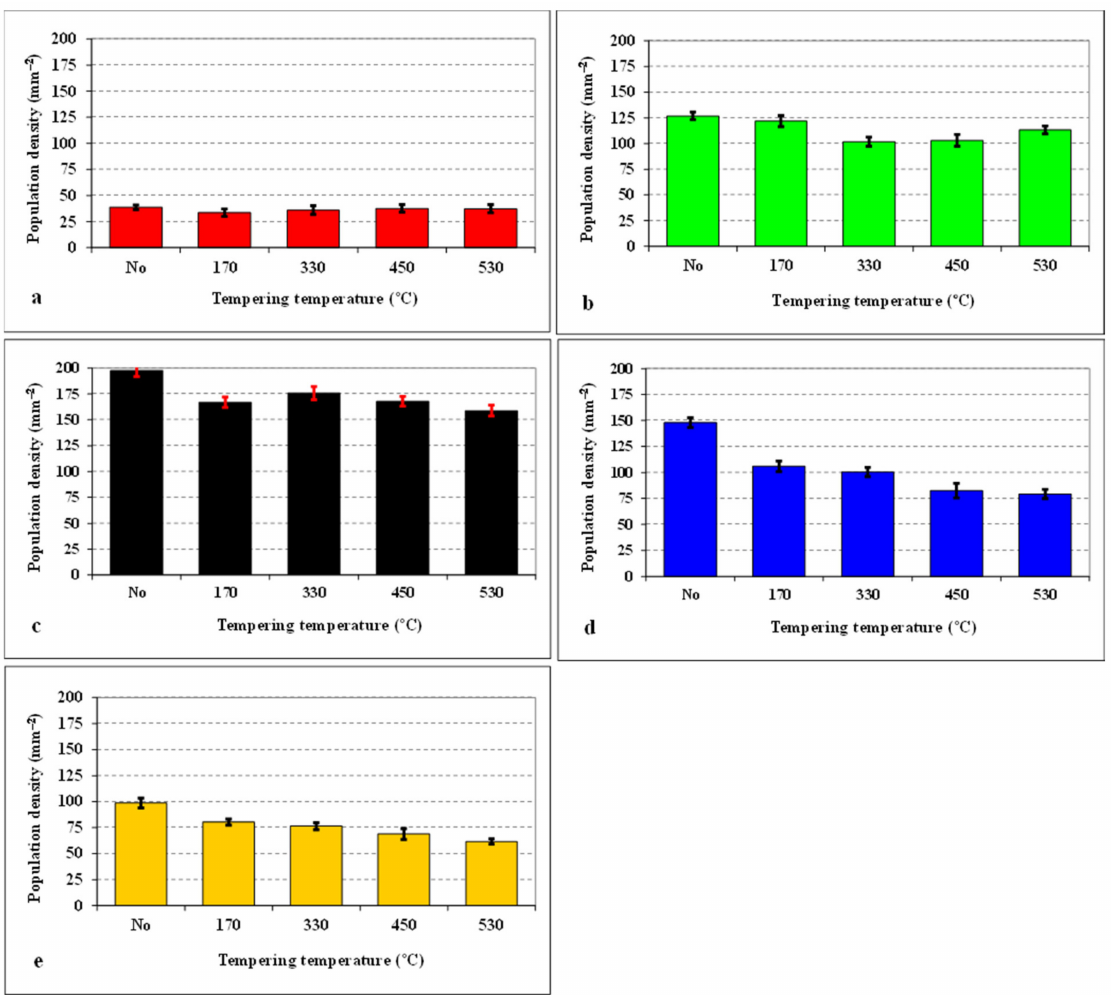
Figure 3. Population density of small globular carbides (SGCs) for differently sub-zero treated (SZT) specimens as a function of tempering temperature: ( a ) conventional heat treatment (CHT), ( b ) SZT − 75 ◦ C, ( c ) SZT − 140 ◦ C, ( d ) SZT − 196 ◦ C, ( e ) SZT − 269 ◦